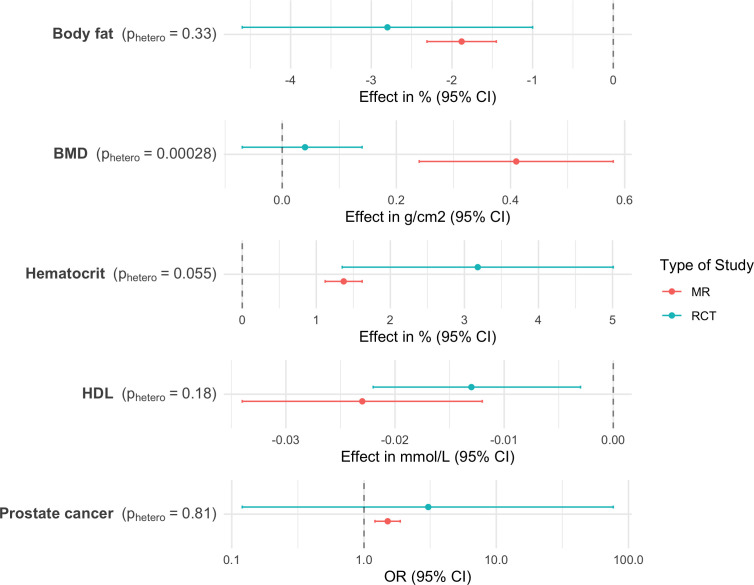
Comparison of effect sizes reported in randomized controlled trials and Mendelian randomization analyses.Error bars indicate 95% confidence intervals around the effect estimate. MR effect estimates are reported in terms of 0.1 nmol/L of CFT to approximate expected effect sizes after initiation of testosterone treatment (Bhasin et al., 2018b).